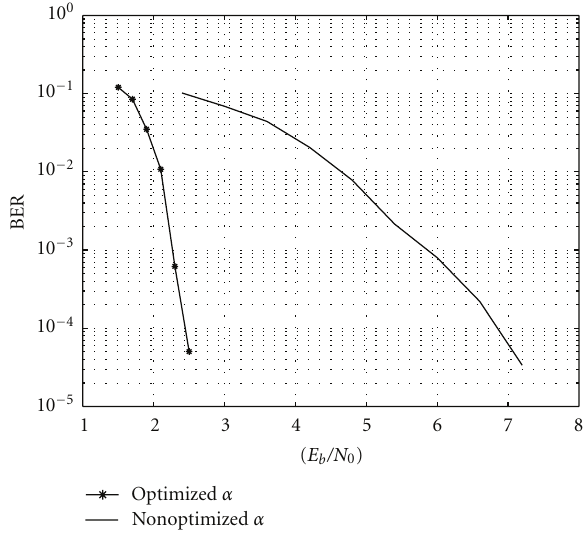
Figure 4: E ff ect scaling factor of (16, 11, 4) 3 for 12th iterations on IGAD1.